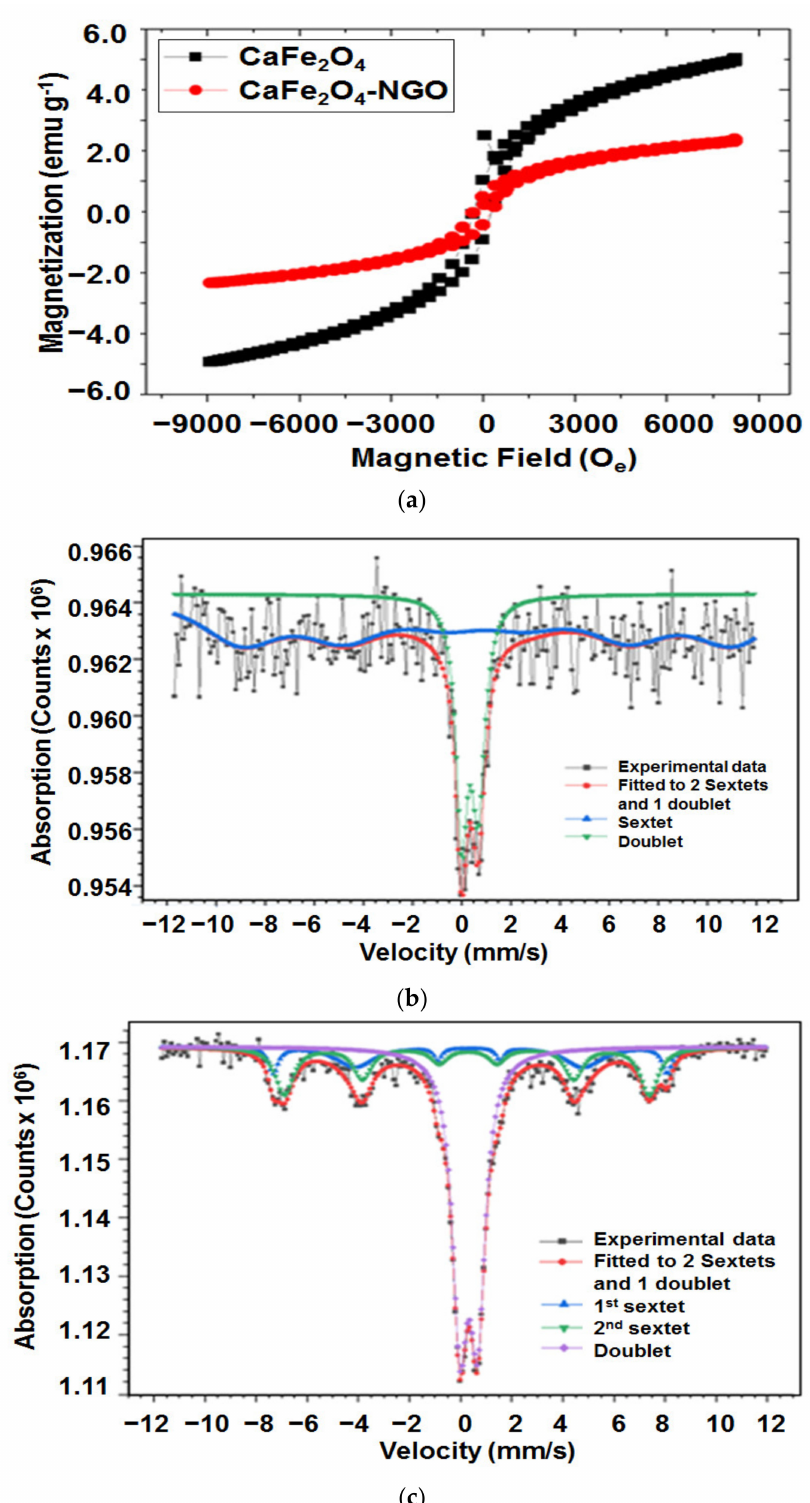
Figure 5. ( a ) Hysteresis loop for CaFe 2 O 4 and CaFe 2 O 4 -NGO and ( b and c ) Mossbauer spectra of MgFe 2 O 4 and MgFe 2 O 4